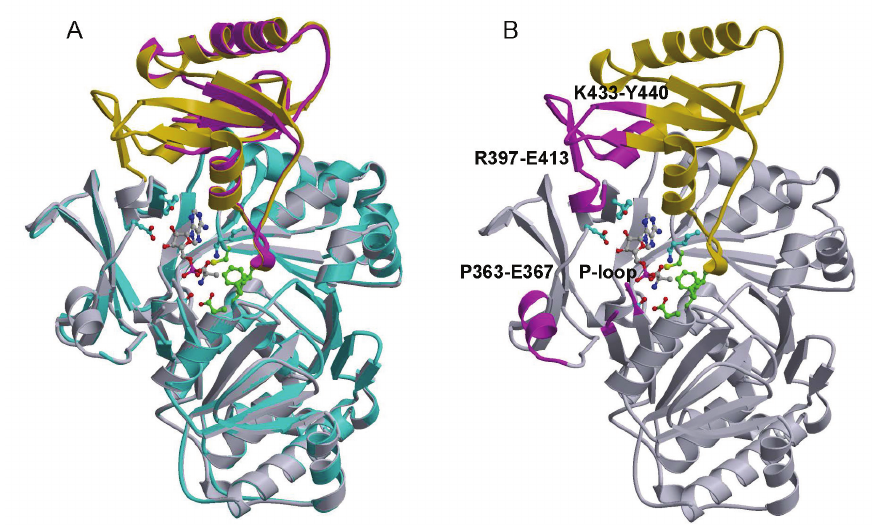
Figure 2. Structure of DltA in the absence of substrate. The ribbons representation of previously reported BcDltA structure (PDB entry: 3DHV) is shown with D-alanine-adenylate and surrounding side-chains in ball-and-stick model. The N-terminal domain is shown in gray, and the C-terminal domain in gold. A . The substrate-free structure of BcDltA is superimposed on the BcDltA/D-Ala-AMP complex. The N- and C-terminal domains are colored in cyan and magenta, respectively. B . The four corresponding regions of the BcDltA/D-Ala-AMP complex, which are disordered in the substrate-free form of BcDltA, are highlighted in